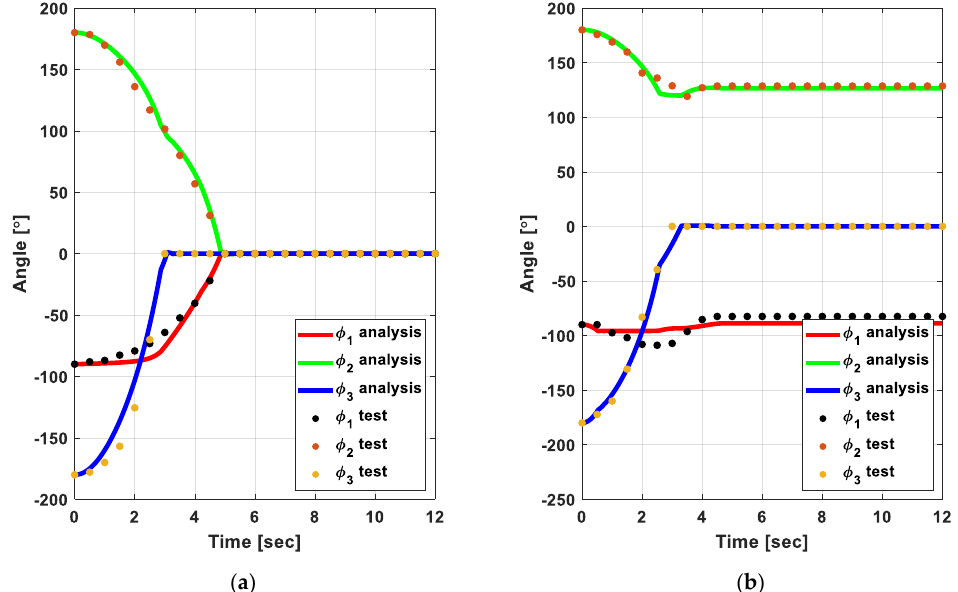
Figure 11. Comparison of the time history of angular displacements after EFT and test frames consideration for test cases: ( a ) T01, ( b ) T02.